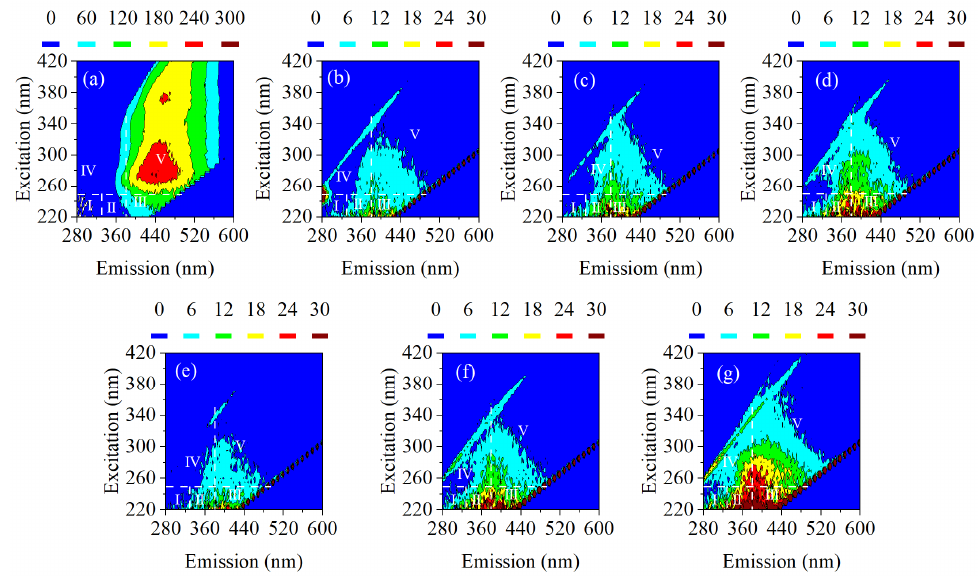
Figure 6. Excitation and emission matrix (EEM) fluorescence spectra of humic acid (HA) solutions: without any treatment ( a ); in 420 min catalytic air oxidation using NCO ( b ), NCO-RB 10 ( c ), NCO-RB 15 ( d ), NCO-RB 20 ( e ), NCO-RB 25 ( f ), and NCO-RS 20 ( g ) as the catalysts; the region I and II refer to aromatic protein components, the region III refers to fulvic-like components, the region IV refers to proteins or polysaccharides, the region V refers to humic-like components a . a The division of region I − IV in ( a ) − ( g ) was based on the method of Tao et al [32].